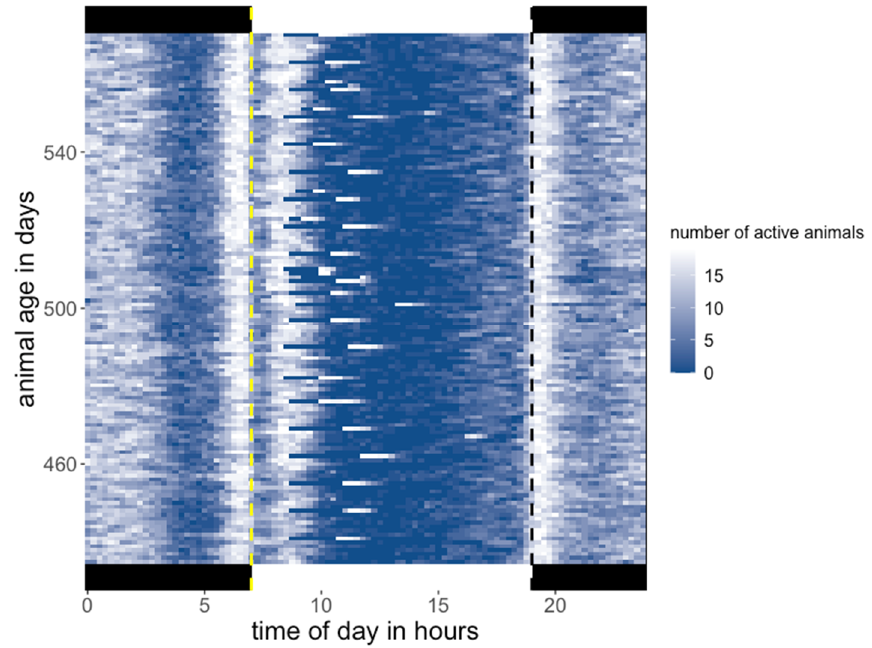
Figure 4. Heatmap of active animals in the SNE. Thy Y-axis shows the age of the animals in 136 consecutive days (day 434–day 570). Animals are recorded as active if there were at least a contact with two different antennas within a 15 min time period. The brighter a 15 min area, the more animals were recorded as active. The changing of the light/dark phase is marked by the dashed lines (yellow line = lights on, grey line = lights off).